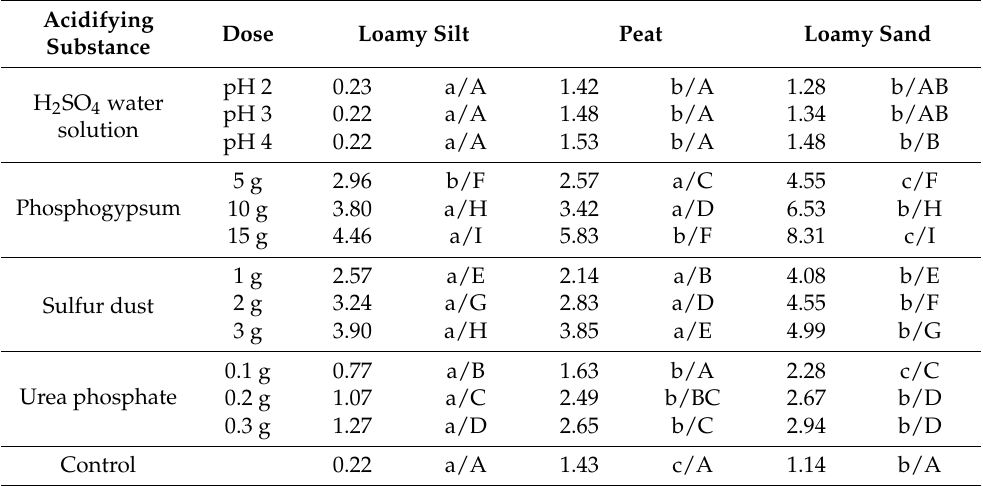
Table 2. Effects of acidifying substances after 12 months on the salinity of loamy silt, peat and loamy sand (g/kg NaCl). Acidifying Dose Loamy Silt